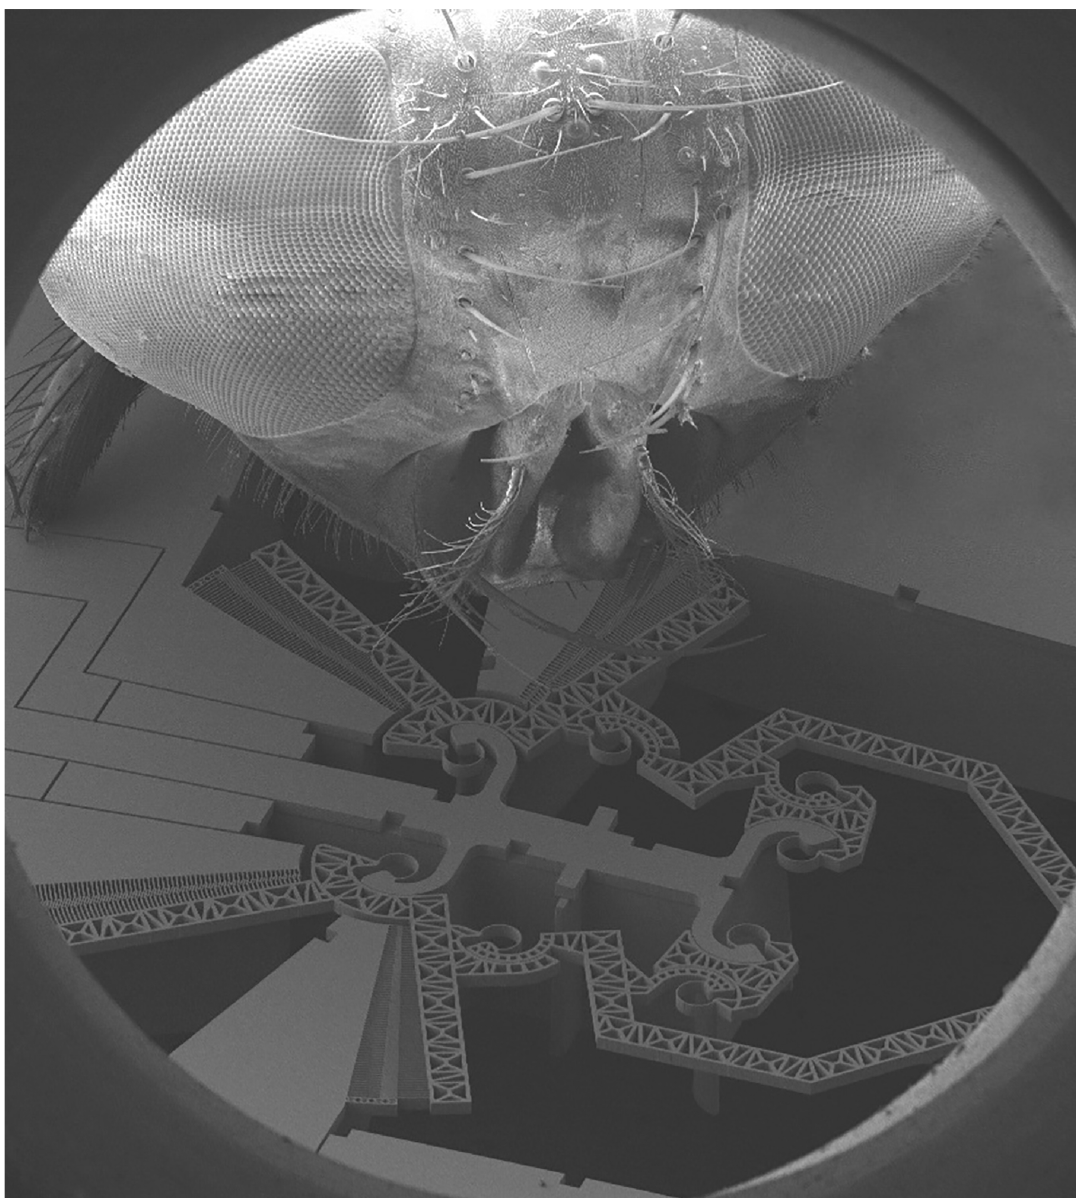
Figure 2. SEM image obtained by Alvise Bagolini and Michele Fedrizzi at Micro Nano Fabrication and Characterization Facility, Fondazione Bruno Kessler, Trento, Italy (PS the housefly has been found dead in Villamontagna, Trento, Italy and no harm has been inflicted to the poor